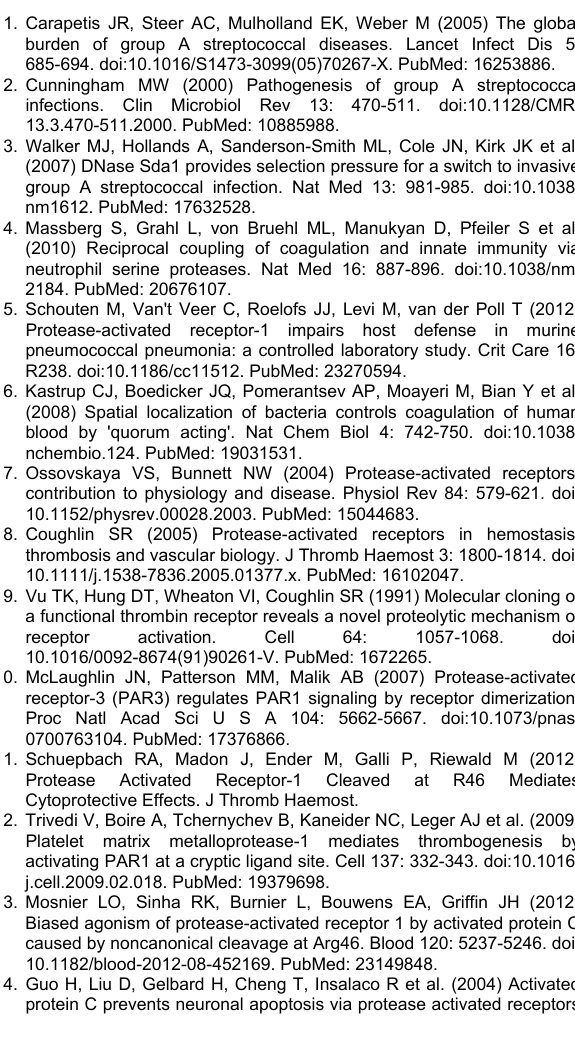
Table S1. Characteristics of GAS clinical isolates. (TIFF) Table S2. Amino acid sequences of PAR reporter constructs. (TIFF) Table S3. Amino acid sequences encoding mutants of PAR1 reporter